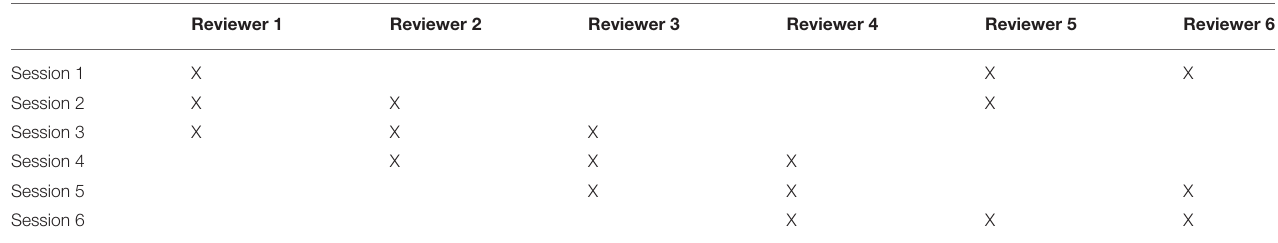
TABLE 1 | Matrix for objective reviewer and ECHO session